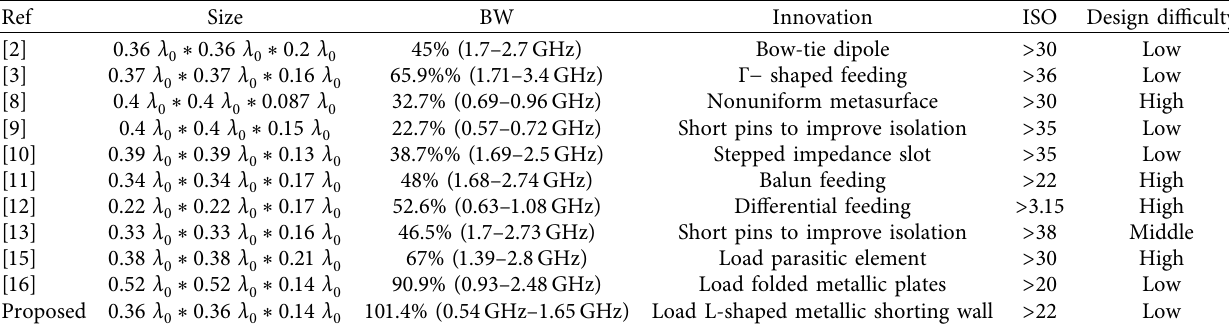
Table 2: Comparison with reported wideband dual-polarized